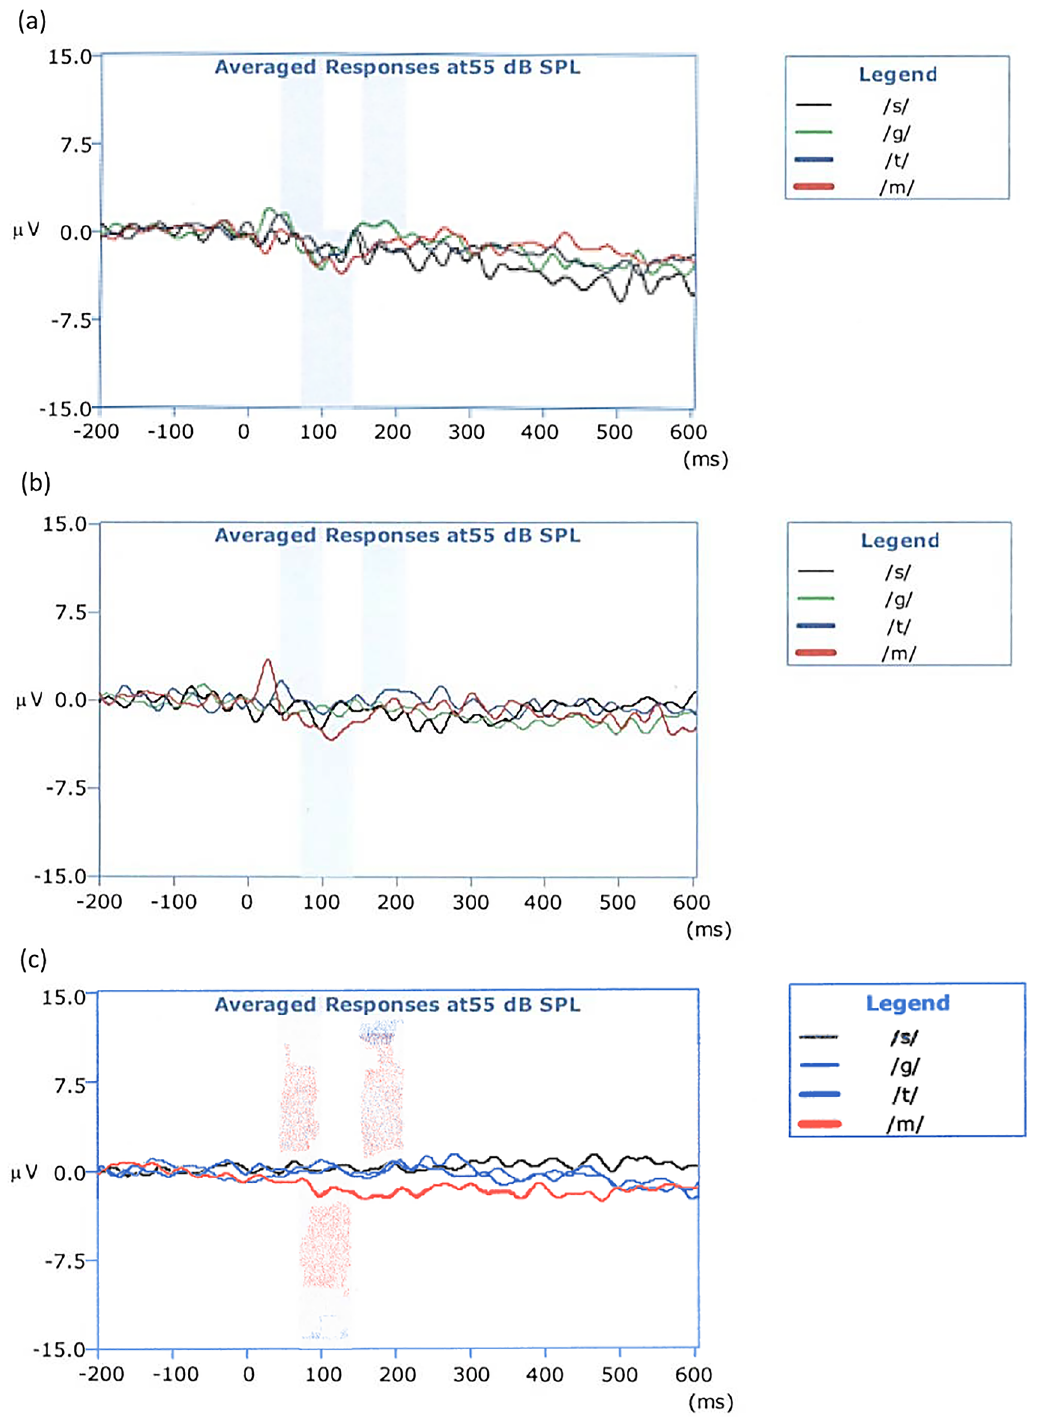
Fig 1. Subject S1’s CAEP traces evoked by speech tokens /s/, /g/, /t/, /m/ with CI off and his normal hearing ear masked with 60 dB HL (1a), 65 dB HL (1b), and 70 dB HL (1c) broad-band noise.